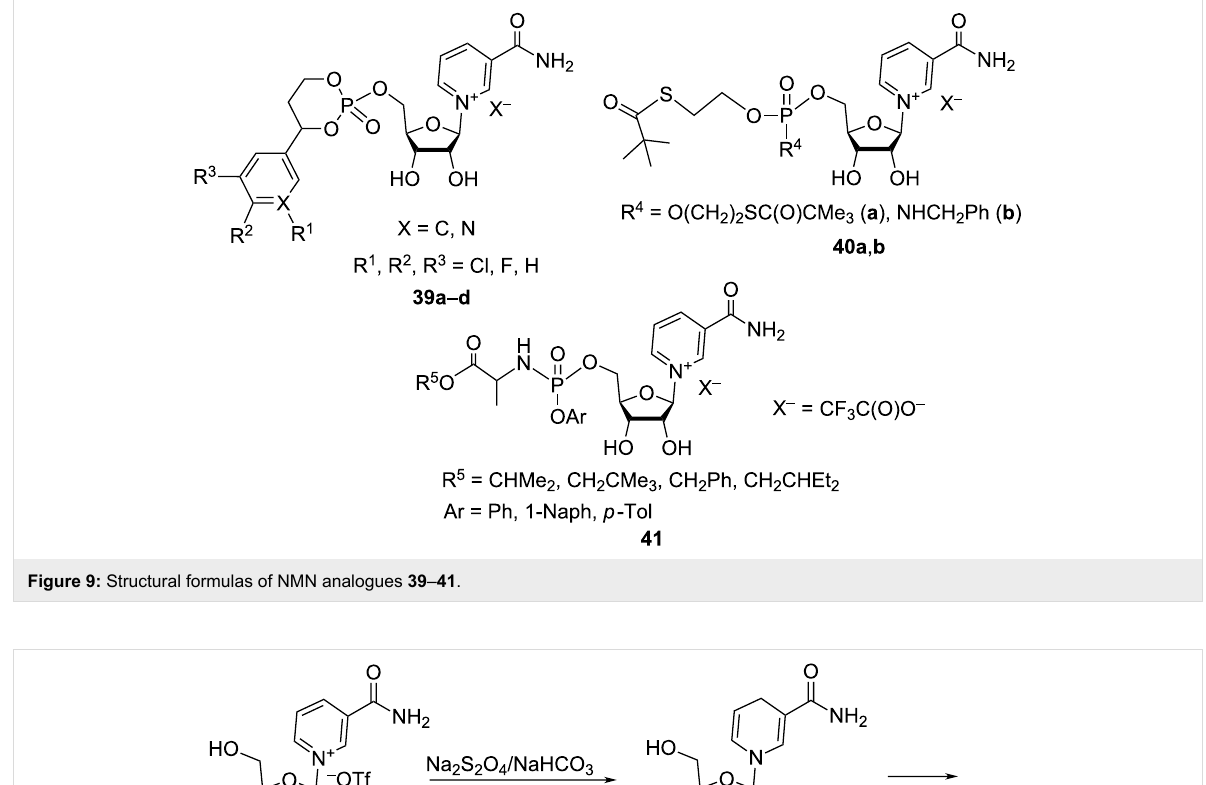
Figure 9: Structural formulas of NMN analogues 39 – 41